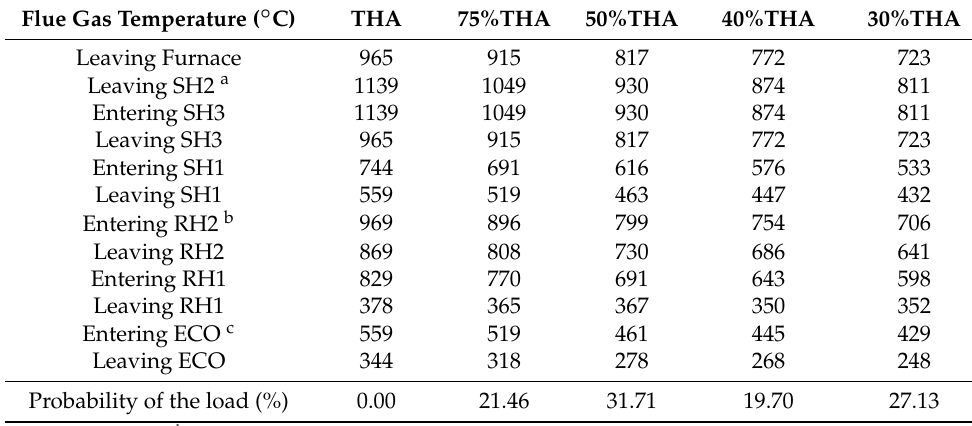
Table 8. Flue gas temperature at different load positions and probabilities.